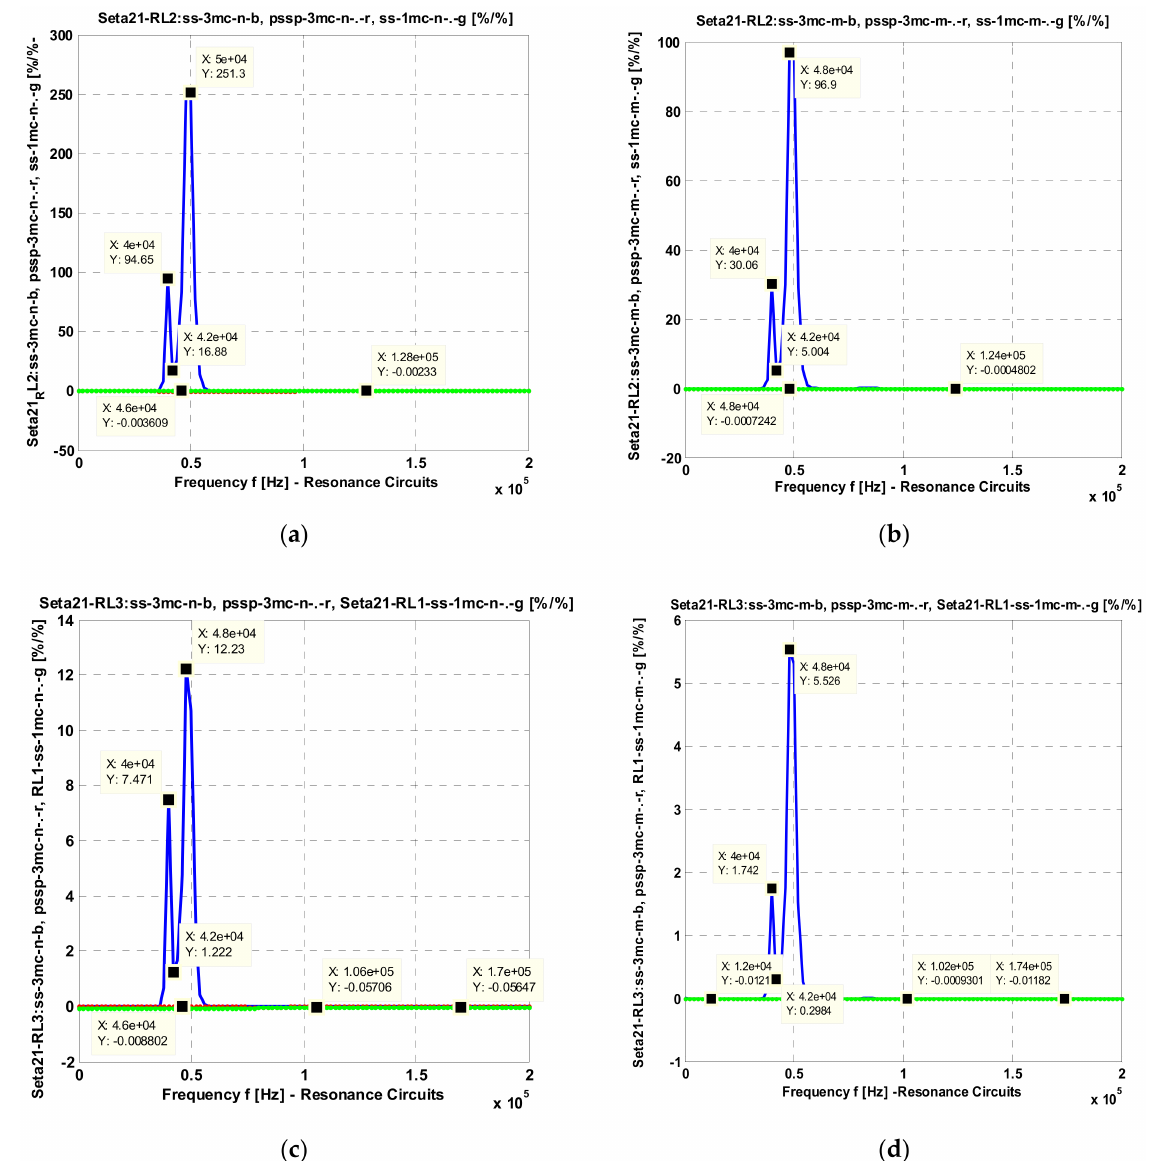
Figure 7. The dependences on frequency of the normalized sensitivity of the active power transmission efficiency in relation with the resistances RL2 and RL3 of circuits (coils) 2 and 3: ( a ) S η 21 for connections ss-3mc-n, pssp-3mc-n and R L 2 ss-1mc-n; ( b ) S η 21 for connections ss-3mc-m, pssp-3mc-m and ss-1mc-m, when the values of the resistances RL2 and RL3, R L 2 for connections ss-3mc and pssp-3mc-m, and the values of the resistances RL1 and RL2 for connection ss-1mc, respectively, are five times reduced; ( c ) S η 21 for connections ss-3mc-n, pssp-3mc-n and ss-1mc-n; ( d ) S η 21 for connections ss-3mc-m, R L 3 R L 3 pssp-3mc-m and ss-1mc-m when the values of the resistances RL2 and RL3, for connections ss-3mc and pssp-3mc-m, and for the values of the resistances RL1 and RL2 for connection ss-1mc, respectively, are five times